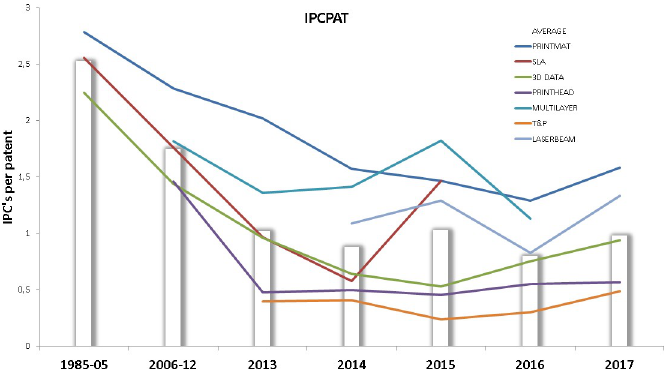
Fig 14. IPCPAT for each technology front. This figure shows the evolution of IPCPAT indicator for each technology front. Data points above the bars indicate higher than average IPC’s per patent rates.